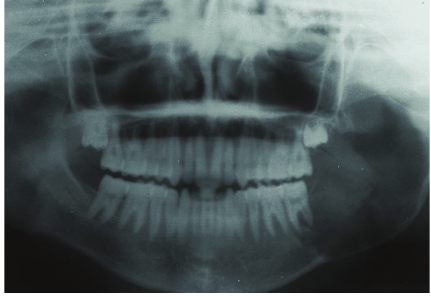
Figure 2: Panoramic radiograph showing the tumor at the left ram- us of the mandible.